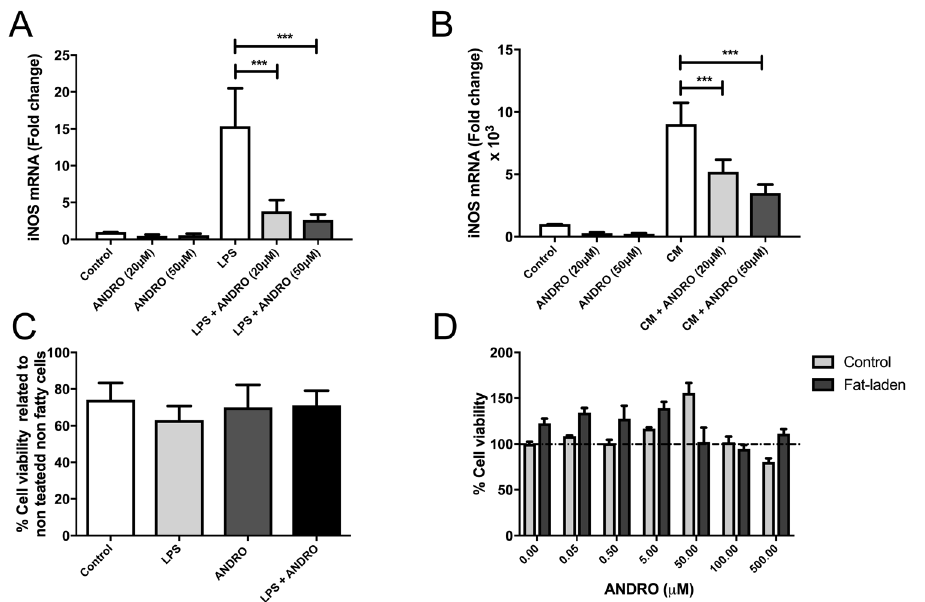
Figure 9. Andrographolide (ANDRO) inhibits inducible nitric oxide synthase (iNOS) expression in hepatocytes. iNOS gene expression was evaluated in freshly isolated hepatocytes that were incubated for 24 hours with LPS (A) or a Cytokine Mixture (B) containing TNF- α , Interleukin-1 and interferon- γ in the presence or absence of different concentrations of ANDRO. To evaluate cell viability under the experimental condition a MTS cell proliferation assay (C) and a dose-response curve (D) were performed in these settings. The statistical significance was evaluated using ANOVA with a post-hoc Bonferroni multiple-comparison test ( *** p ≤